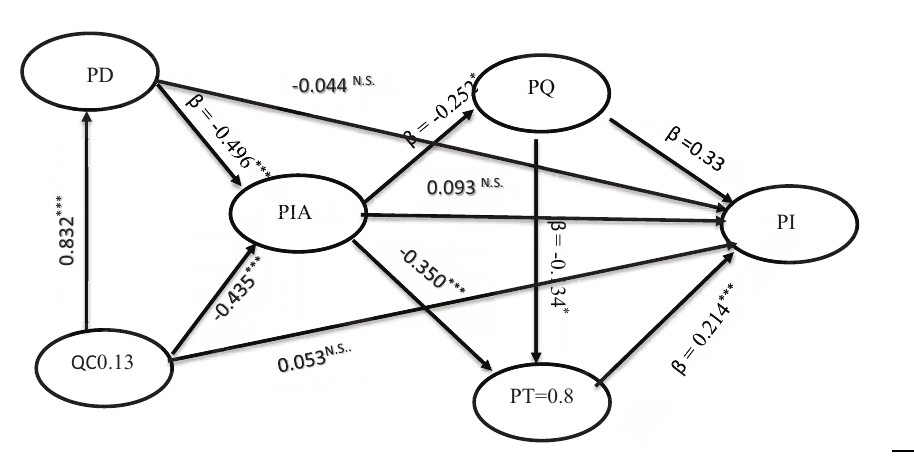
Figure 2. Validated research